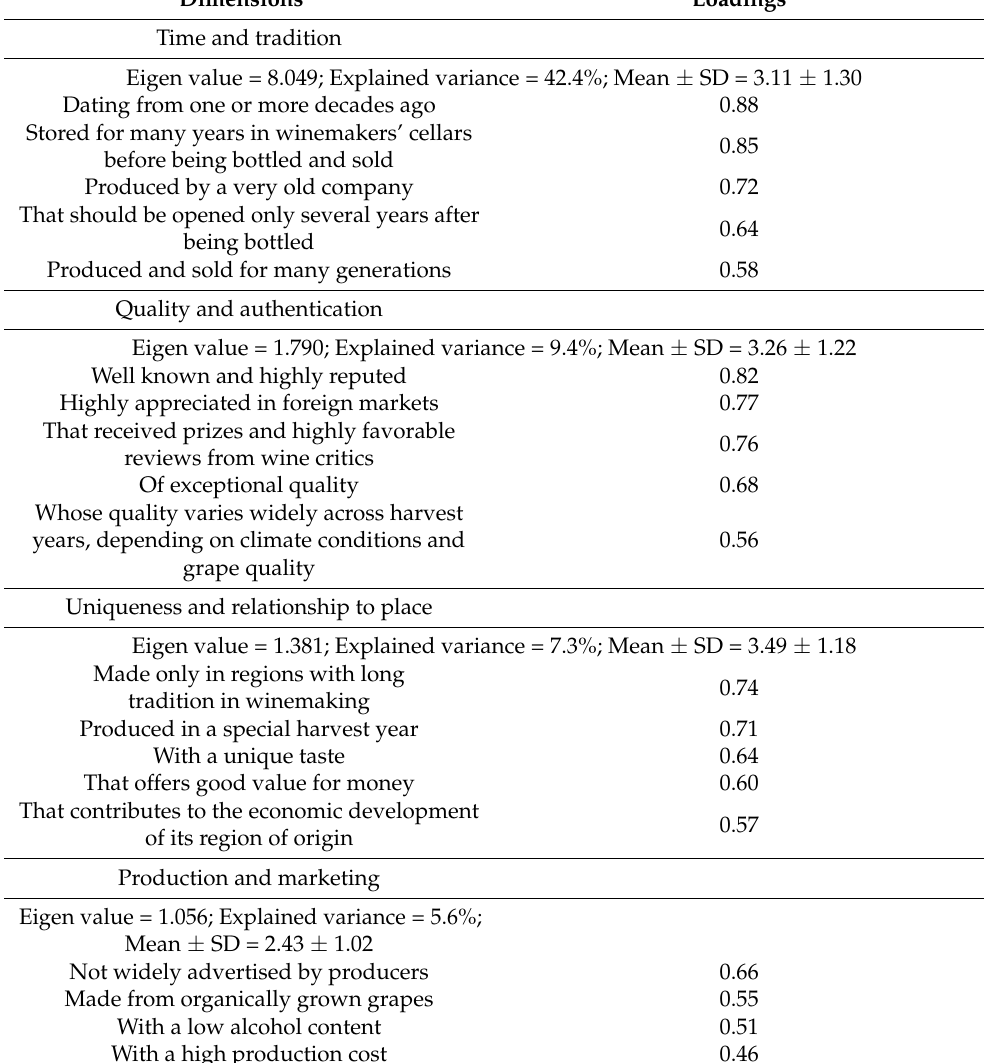
Table 2. Factor analysis of the attributes Portuguese wine consumers (n = 641) associated to a wine classified as HWP in the online